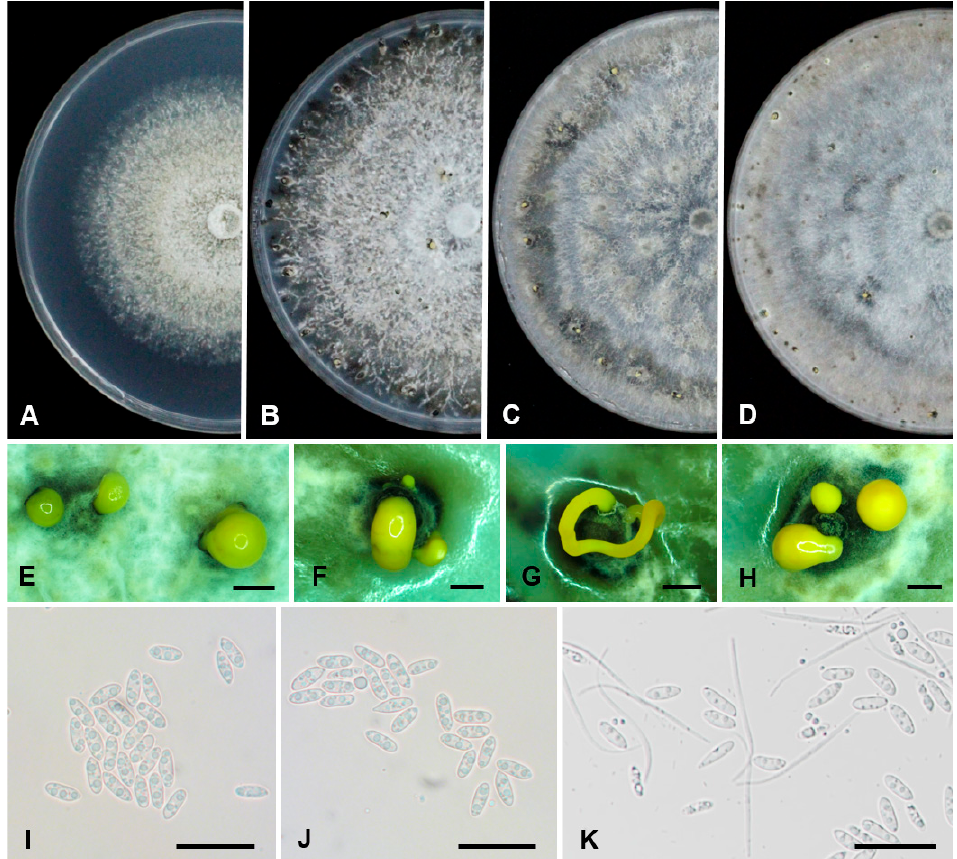
Figure 4. The morphology and cultural characteristics of D. citri isolate NFHF-8-4. ( A , B ) culture on PDA medium after 7 and 30 days, respectively. ( C , D ) colony morphology after 30 days on CMA and OMA media, respectively. ( E – H ) mucilaginous drops or tendrils of conidia on PDA. ( I , J ) alpha conidia. ( K ) alpha- and beta conidia. Scale bar, E – H = 200 μ m; I – K = 25 μ m.